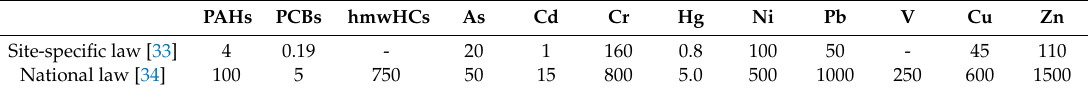
Table 1. Concentration limits for soil pollution by organic compounds and metals